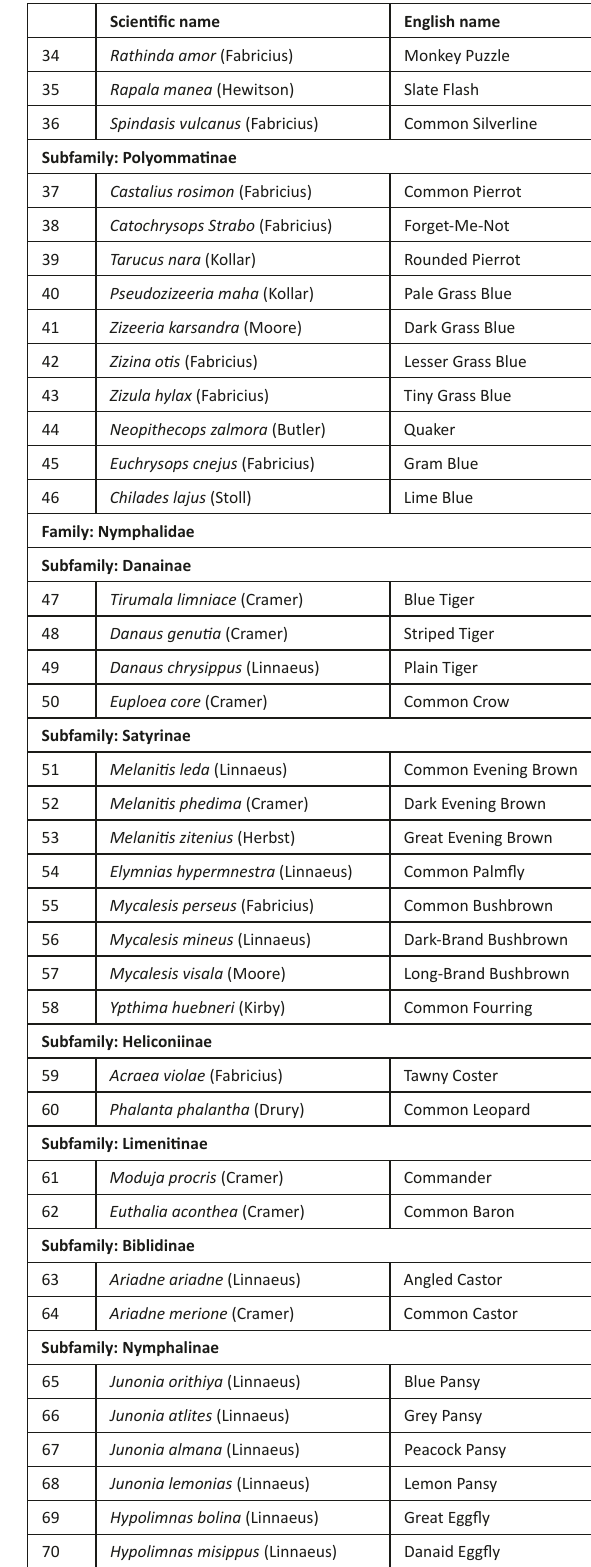
Table 2. Detailed checklist of the butterflies of RRS, Chinsurah and adjoining